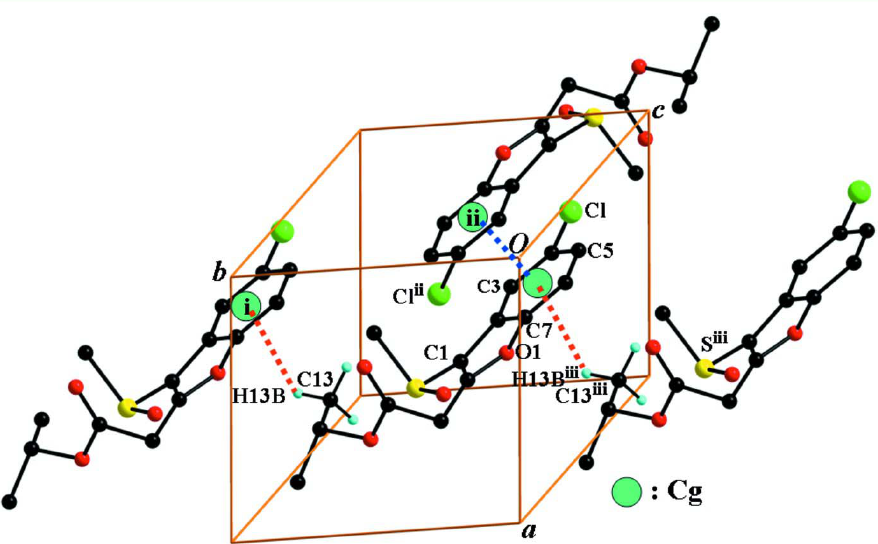
Figure 2 π — π and C—H··· π interactions (dotted lines) in the title compound. Cg denotes ring centroid.[Symmetry code: (i) x , y +1, z ; (ii) - x +1, - y +1, - z +2; (iii) x , y -1, z